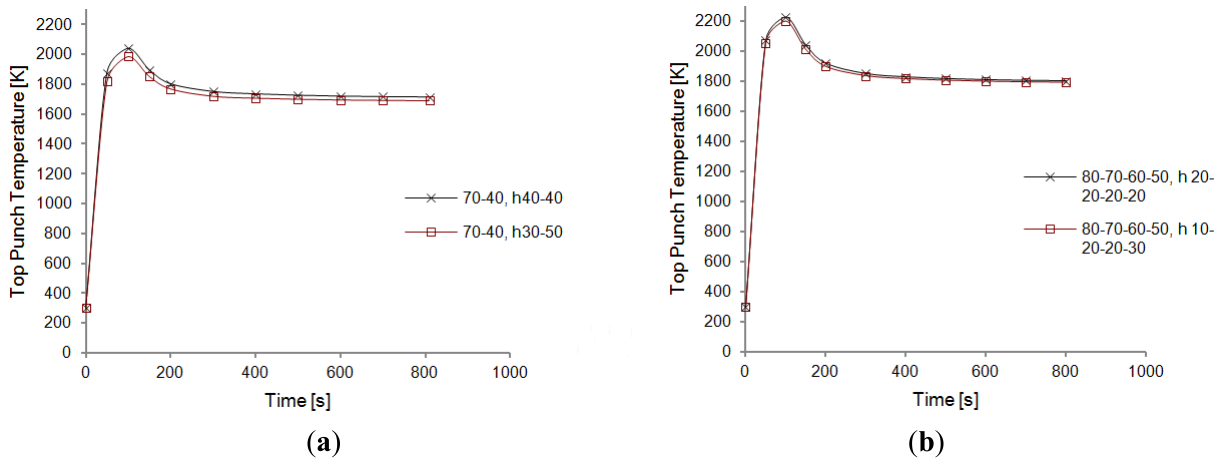
Figure 11. Temperature evolution—Effect of height variation. ( a ) two transitional disks—Ideal contact—Radii 70 and 40 mm—Height 40 mm each compared with 30 and 50 mm; ( b ) four transitional disks—Resistive contact—Radii 80, 70, 60, and 50 mm—Height 20 mm each compared with 10, 20, 20, and 30 mm. Dimensions of the setup are listed in the legend. The first three values correspond to disks radii, from top to bottom; the last three values (marked by the letter “h”) indicate the respective